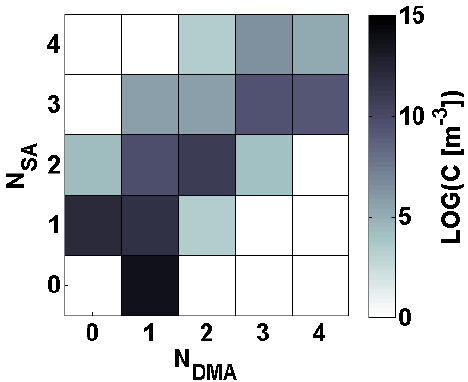
Fig. 4. The steady-state concentrations of clusters consisting of 0–4 sulfuric acid and 0–4 DMA molecules. The colour scale gives the base-10 logarithm of the concentration (in m − 3